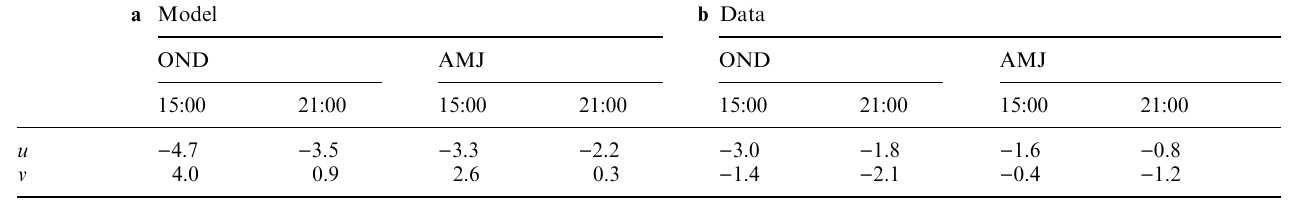
10 m above surface. The data are obtained from the Meteorolo- gical Station in Cabo Frio (point F in Fig. 1) for 10-y means, 1971– 1980. Units are m s ) 1